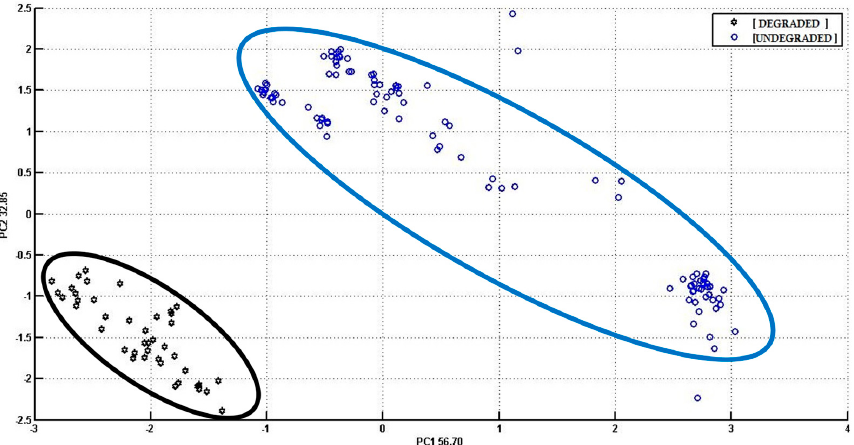
Figure 5. PCA score plot (PC1 versus PC2) from S3 measurements related to the sensor array response to the volatiles of degraded and undegraded cheese samples showing the clusters represented by black and blue circles, respectively. Explained variance: PC1 = 56.70%, PC2 = 32.85%.